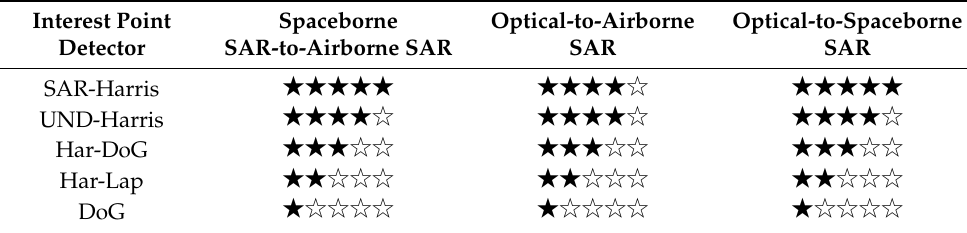
Table 3. Image Alignment Performance Score.